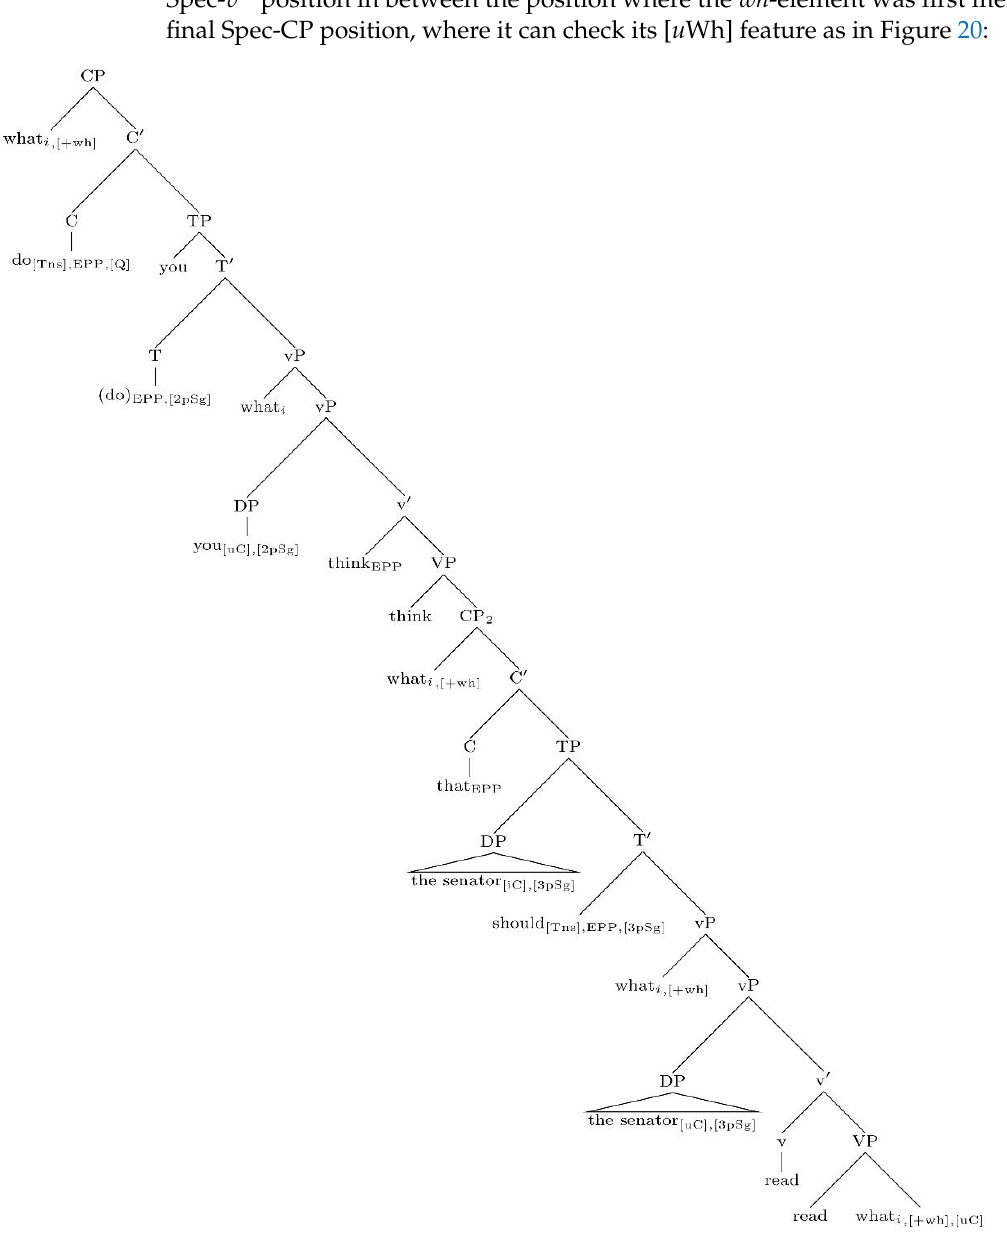
Figure 20. Minimalist derivation for ‘What do you think that the senator should read?’ One of the fundamental questions when analysing filler-gap dependencies is whether movement is necessary at all. Non-transformational generative theories of displacement (e.g., LFG, HPSG) have been very successful since the late 1970s, and some versions of TAGs [18,28,58] are indeed non-transformational in the sense that they do not include rules for singulary transformations (such as wh -movement), but only generalised transformations (specifically, substitution and adjunction ) and (in some cases) the concept of links . This is not to say that TAGs are inherently incompatible with singulary transfor- mations; as a matter of fact, the version of TAG explored in [19,21] is closer to transforma- tional generative models than to non-transformational models (read: “ without singulary transformations ” ). The TAG formalism specifies how elementary trees are put together (and, if each elementary tree receives a local semantic interpretation, then it also defines a theory of compositionality), but it remains agnostic about the operations that apply within elementary trees; these are subject to independent empirical inquiry.